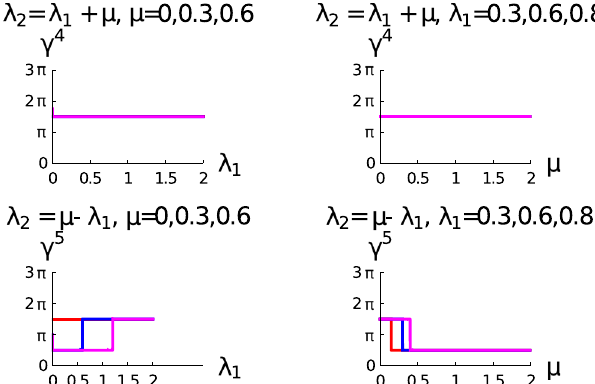
Figure 4. The left and the right column show the variation of geometric phase ( γ ) with λ 1 and μ respectively. The upper and lower rows are for λ 2 = μ + λ 1 and λ 2 = μ − λ 1 respectively. The curves in the right column of this figure are red, blue, and magenta for μ = 0,0.5 and 1 respectively. The curves in the left column of this figure are red, blue, and magenta for λ 1 = 0.3,0.6 and 0.8 respectively.